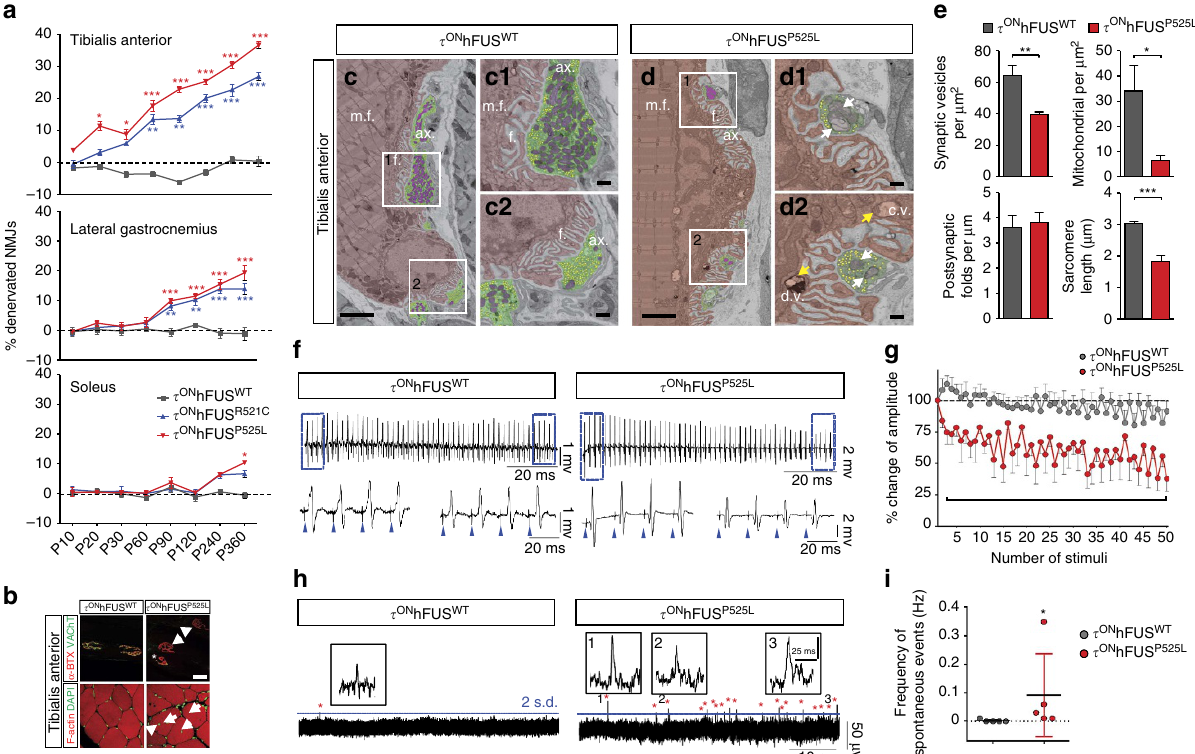
Figure 4 | Mutant FUS causes early synaptic changes at the neuromuscular junction, leading to progressive and selective denervation. ( a ) Denervated NMJs in the TA, GS and SOL of t ON hFUS WT (grey), t ON hFUS R521C (blue) and t ON hFUS P525L (red) animals normalized to controls. N ¼ 4. * P o 0.05, ** P o 0.01 and *** P o 0.001 using one-way analysis of variance with Bonferroni’s post hoc test. Error bars represent s.e.m. ( b ) Co-localization of VAChT- positive motor terminals (green) with acetylcholine receptors ( a -BTX, red) as a marker of innervated endplates. In t ON hFUS P525L animals, denervated endplates (arrows, top right), partially innervated endplates (asterisk, top right) and internal nuclei (arrows bottom left) were observed. Scale bar, 40 m m (top), 20 m m (bottom). ( c , d ) Electron micrographs from TA NMJs in p30 t ON hFUS WT ( c ) and t ON hFUS P525L ( d ) animals, show that motor terminals (ax., green) were correctly opposed to postsynaptic folds ( f ) in the muscle (brown, m.f). Higher magnification of boxes 1 and 2 are shown in c 1 , d 1 and c 2 , d 2 . In t ON hFUS P525L animals, the distributions of mitochondria (purple) and synaptic vesicles (yellow) were altered. Pre- (white arrows, d 1 , d 2 ) and post-synaptic structurally damaged mitochondria (yellow arrows, d 2 ) with clear- and dark-vacuoles (d.v. and c.v., d 2 ) were observed in t ON hFUS P525L animals. Scale bar, 1 m m ( c , d ), 0.4 m m (for c 1 , c 2 and d 1 ,d 2 ). ( e ) Quantification of synaptic vesicles, healthy mitochondria, postsynaptic folds and sarcomere length in NMJs from t ON hFUS WT (grey) and t ON hFUS P525L animals (red). N ¼ 6 junctions, 2 animals. ( f ) EMG responses in the TA following a 50-Hz, 1s stimulation of the sciatic nerve in t ON hFUS WT (left) and t ON hFUS P525L (right) animals. The first and last four responses are shown in an expanded time scale below. Blue triangles mark the stimulus artefact. ( g ) M-responses at subsequent stimuli, normalized to the first response in t ON hFUS WT (grey) and t ON hFUS P525L (red) animals. ( N ¼ 5. * P o 0.05 using two-way analysis of variance with Fisher’s LSD post-hoc test. Error bars represent s.e.m.). ( h ) Spontaneous activity in the TA of t ON hFUS WT (left) and t ON hFUS P525L (right) animals. Examples of spontaneous activity are shown in insets 1–3. ( i ) Frequency of spontaneous events in t ON hFUS P525L (red) and t ON hFUS WT (grey) animals. ( N ¼ 5. * P o 0.01 using t -test. Error bars represent